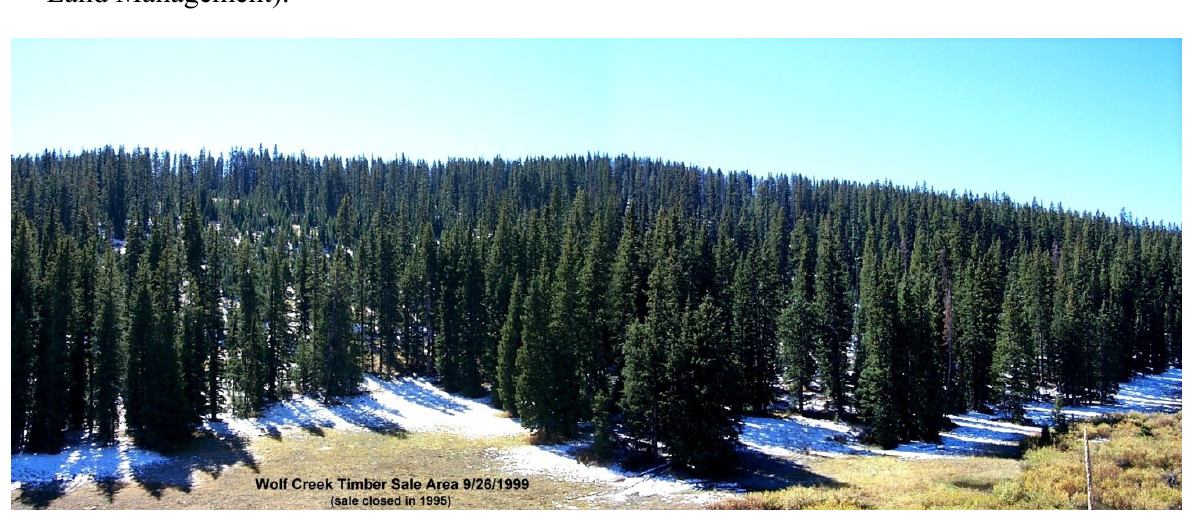
Figure 3. Residual spruce-fir stand following a spruce beetle sanitation/salvage sale, Unita-Wasatch-Cache National Forest, Utah (Photo: Doug Page, Zone Forester, Bureau of Land